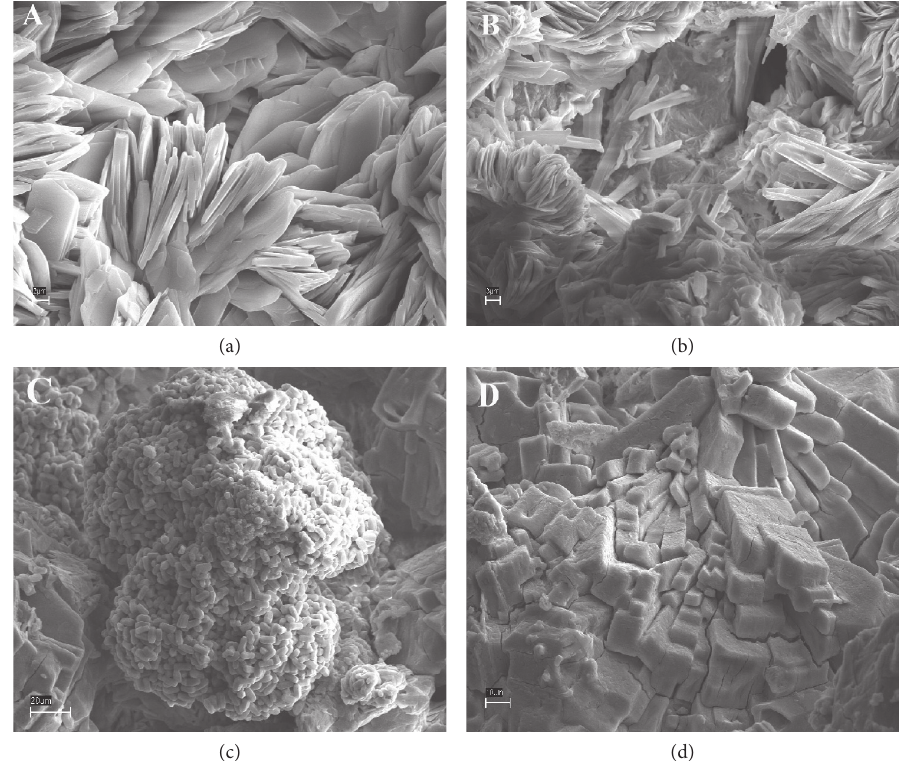
Figure 5: The morphology of sulfates formed in the tailings: (a) laminal fibroferrite, (b) sheaf-like melanterite, (c) hexagonal prisms of copiapite with a truncated bipyramidal tail, and (d) tetragonal prisms of copiapite. Microscopes JSM-6490LV and ZEISS EVO 50XVP. Table 3: Chemical composition of fibroferrite